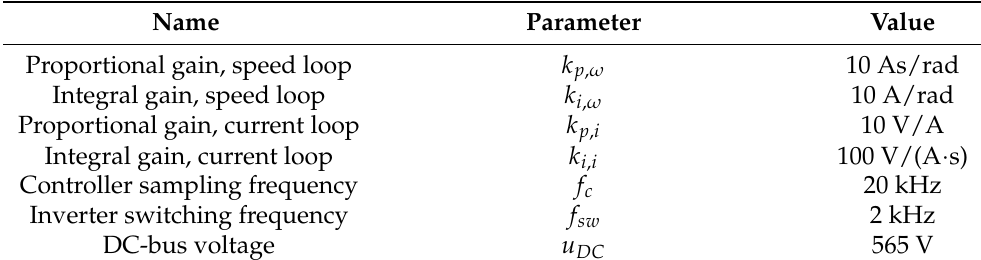
Figure 5. Illustration of the servo drive using FOC. Table 3. Servo drive